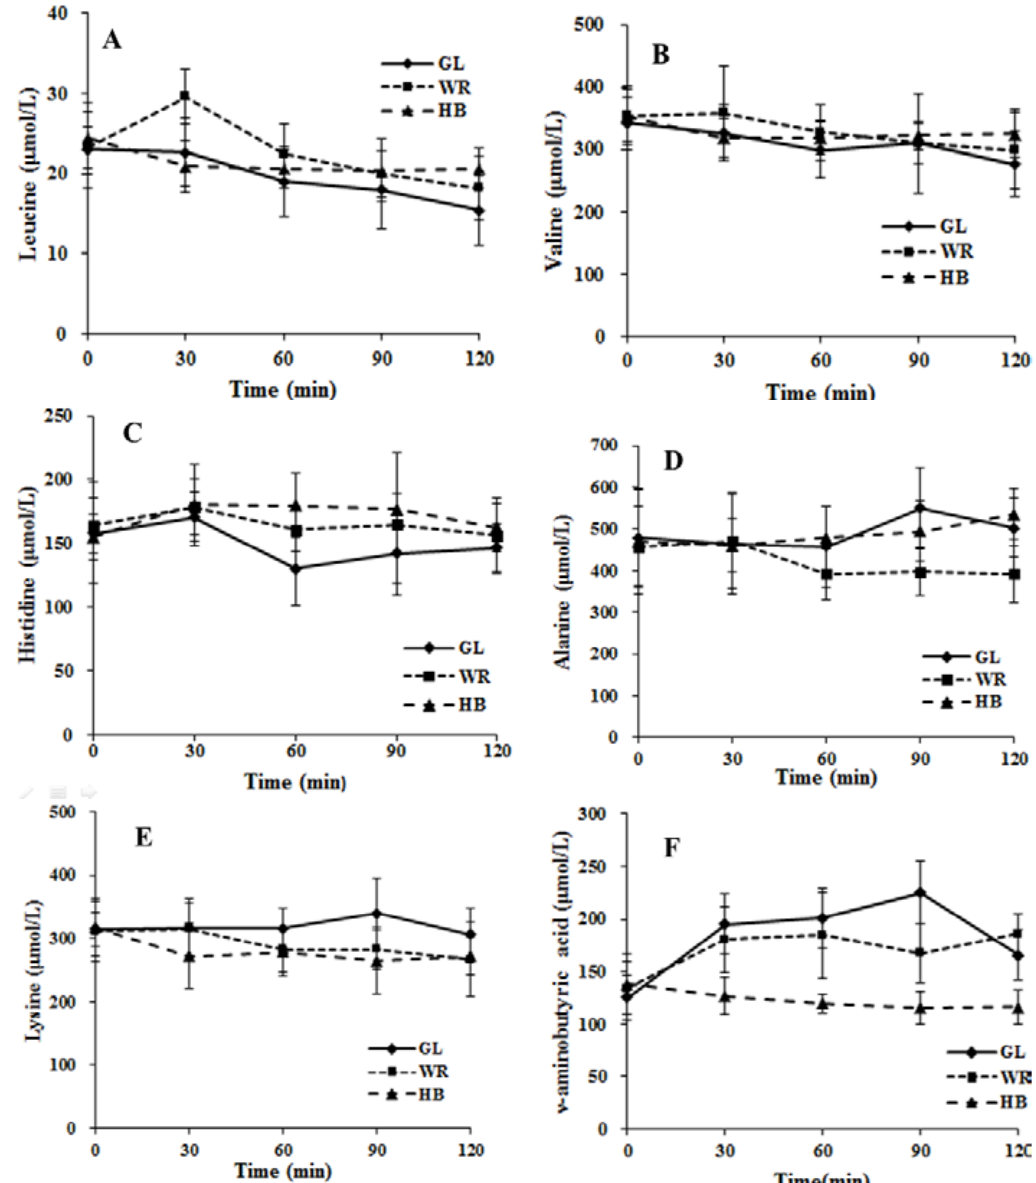
Figure 4. The changes in serum leucine ( A ), valine ( B ), histidine ( C ), alanine ( D ), lysine ( E ) and ν-aminobutyric acid ( F ) during three test loads. Diamond, glucose load (GL); box, WR load (WR); Triangle, HB load (HB). Repeated-measures ANOVA showed significant main effects of test load, time or a time × test load interaction on leucine (test load, p = 0.041; time, p < 0.001; interaction, p = 0.005), valine (test load, p = 0.199; time, p = 0.001; interaction, p = 0.013), histidine (test load, p = 0.008; time, p < 0.001; interaction, p < 0.001), alanine (test load, p = 0.009; time, p = 0.297; interaction, p = 0.005), lysine (test load, p = 0.016; time, p = 0.013; interaction, p = 0.028), ν-aminobutyric acid (test load, p < 0.001; time, p < 0.001; interaction, p < 0.001). Table 2. Associations between glucose, insulin and insulin sensitivity index and percent change of metabolites from fasting to 2-h sample response to three test loads.